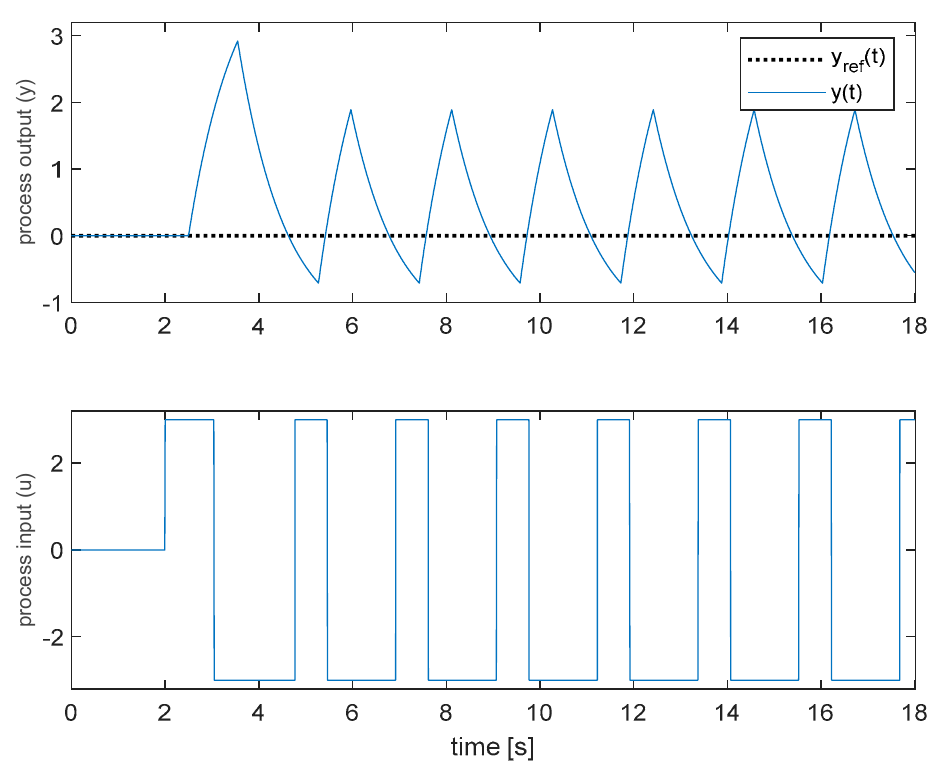
Figure 6. Response of the relay feedback method [1] for the first-order plus time-delay process with θ = 0.5 and PA set = − π .